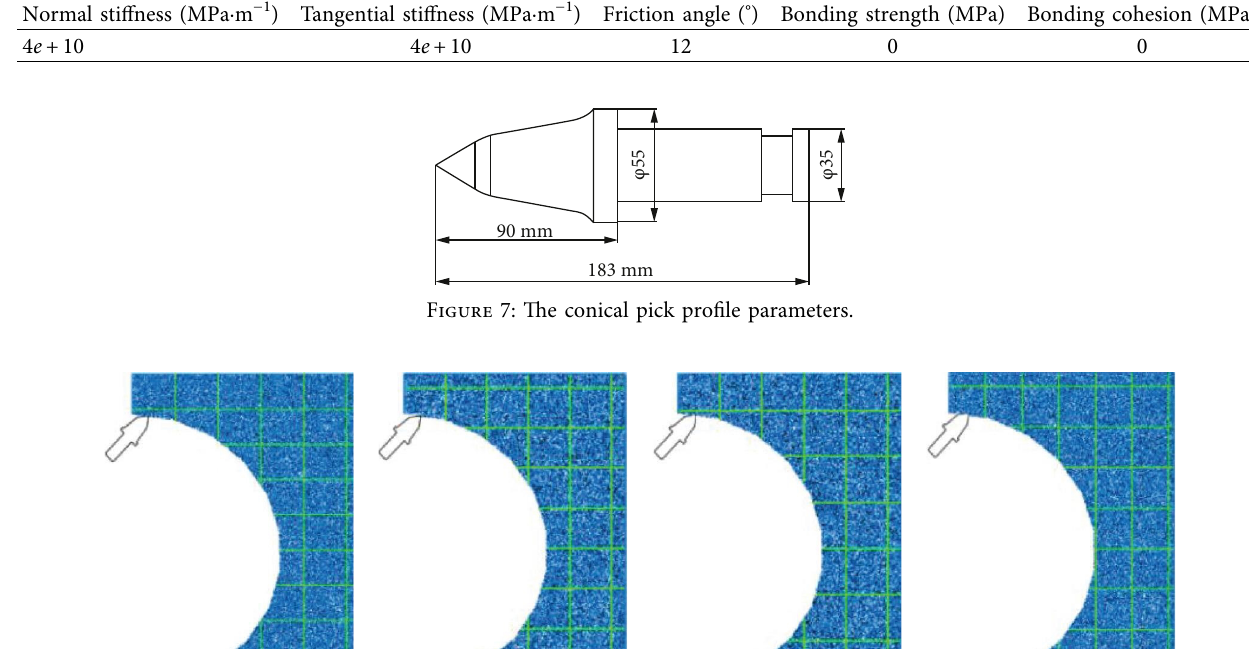
Table 5: The parameters of the mechanical properties of cleats.